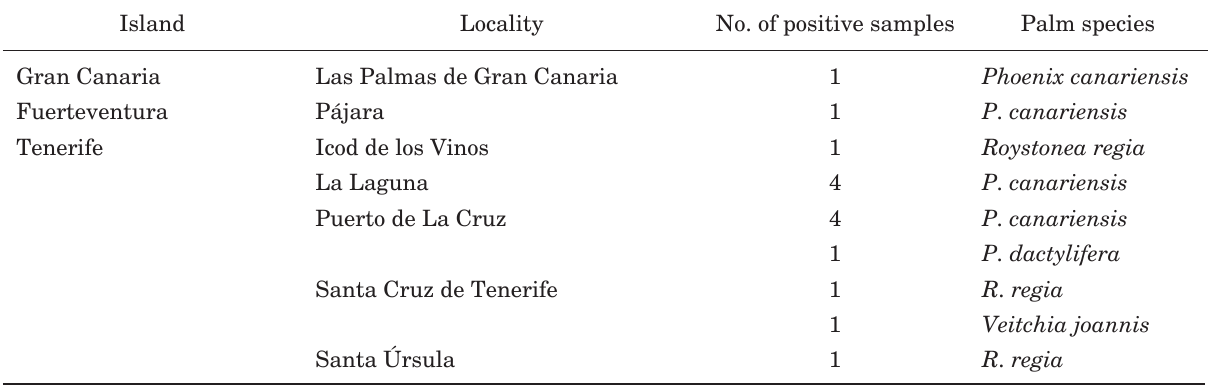
Table 2. Distribution of Fusarium proliferatum in different palm species collected from gardens and public parks in the Canary islands.